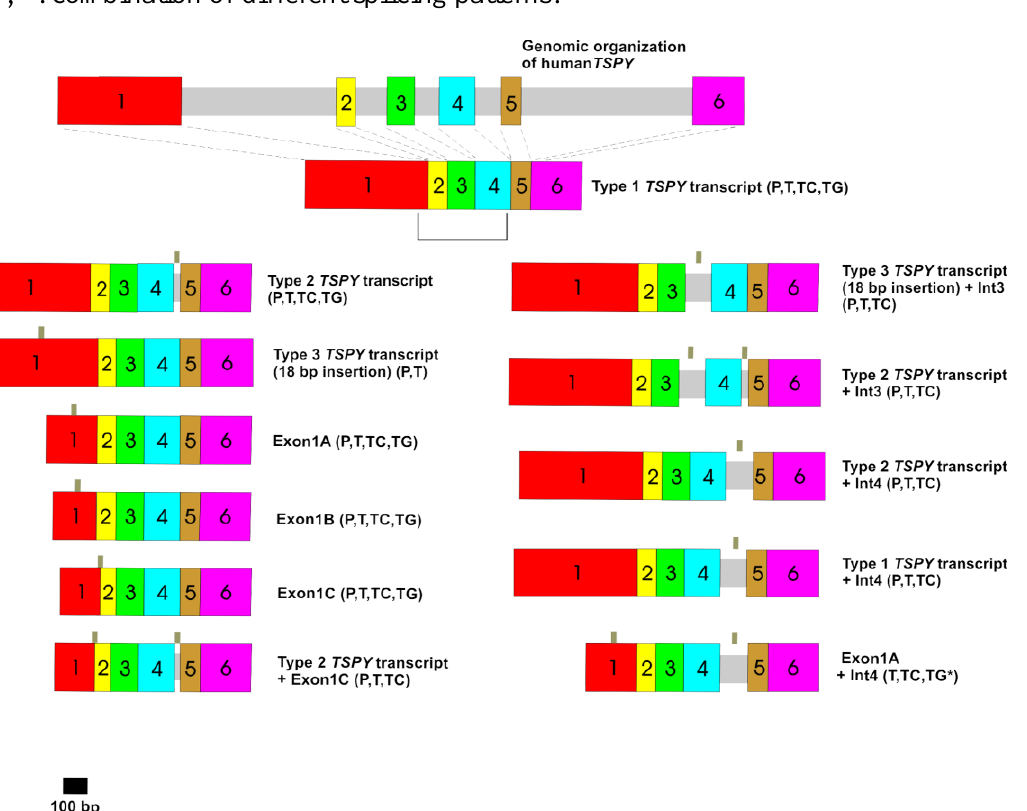
Figure 2. Schematic illustration of a human TSPY gene and the various TSPY transcripts in human prostatic (P, prostatic adenoma and benign prostatic hyperplasia) and testicular (T, human testis; TC, human testicular seminoma) tissues [17] and in mouse testes of the transgenic line Tg(TSPY)9Jshm (TG) [47,50,51]. Introns are shown as grey bars and exons indicated as colored boxes. Small grey bars above the splice variants indicate the use of alternative splice donor and/or acceptor sites. The TSPY cDNA region encoding the cyclin B binding domain (SET/NAP domain) is highlighted by a black line (aa residues 121-265) [22]. * [52]. Detailed descriptions of the differential spliced TSPY transcripts are given in reference [17]. Splice variants are termed in accordance to references [17] and [26]. 18 bp insertion: in frame insertion of GTG GAG CTG GTG GCG CAG within exon 1 of human TSPY , +: combination of different splicing